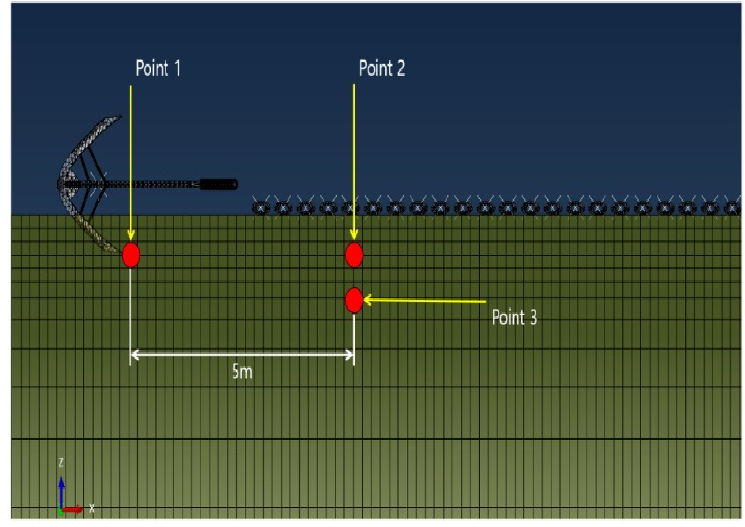
Figure 11. Points used for the observation and analysis of the results.